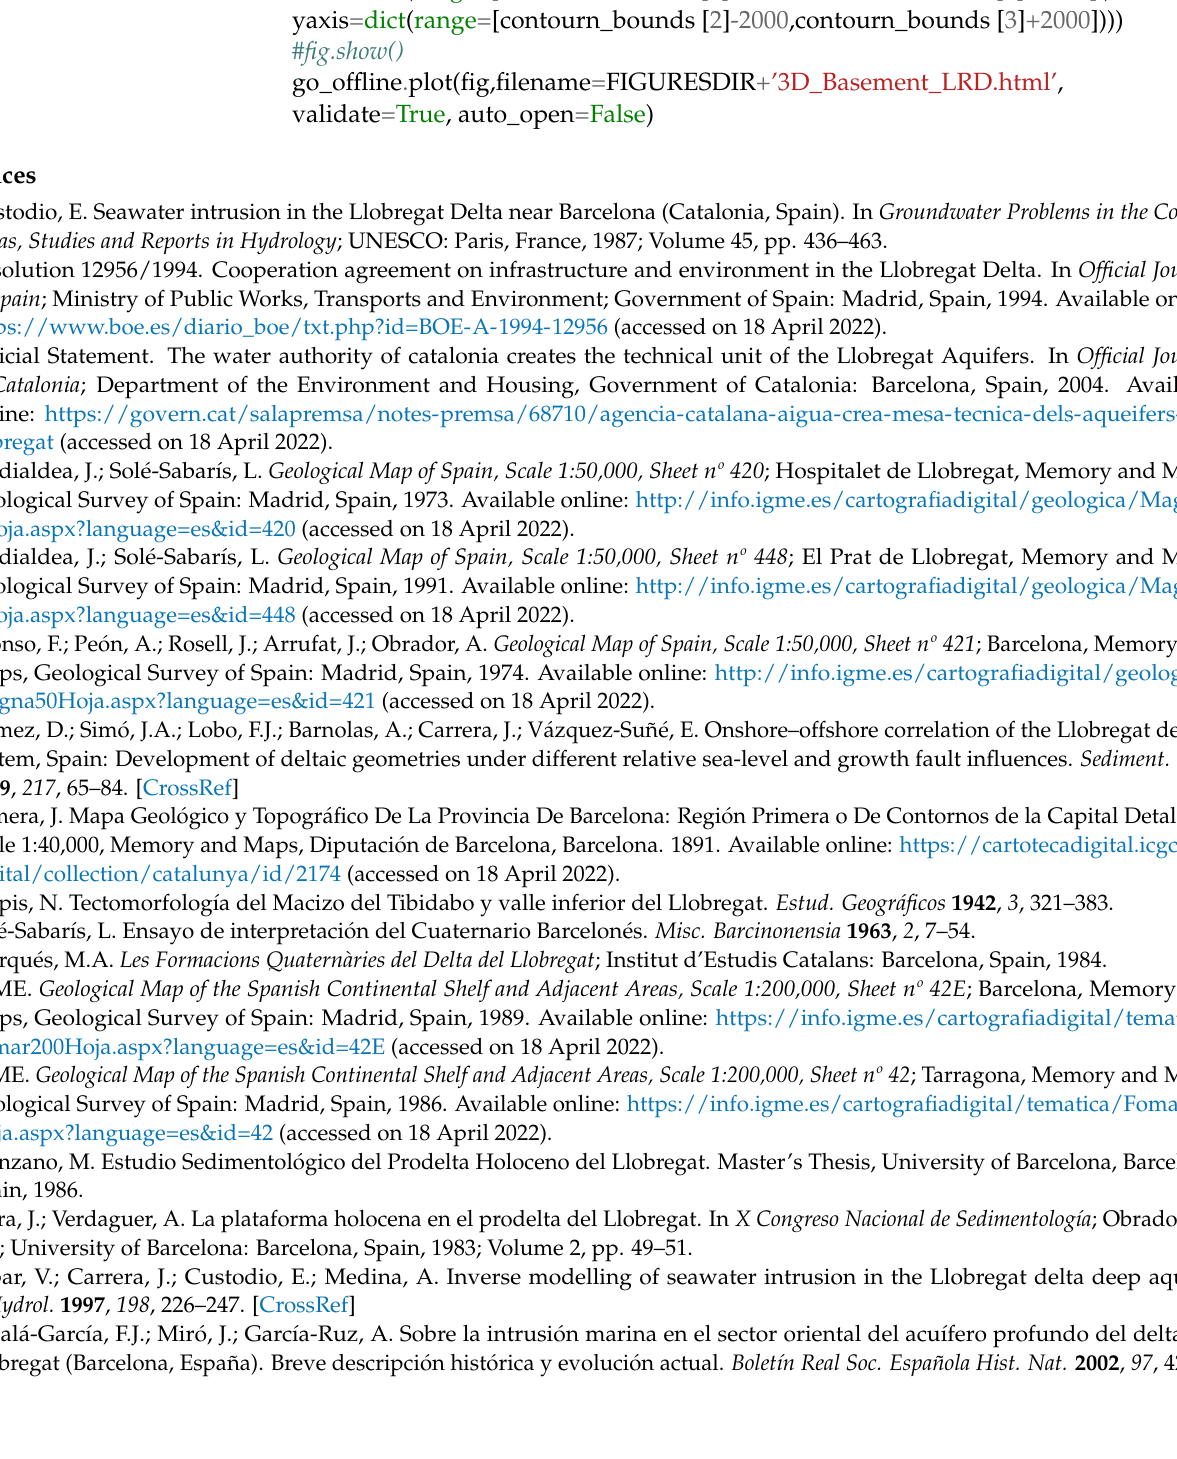
fig.update_layout( title=‘Pliocene basement Llobregat Delta, Z scale is x 50’, scene=dict(aspectratio=dict(x=2, y=2, z=0.5), xaxis=dict(range=[contourn_bounds [0]-2000,contourn_bounds